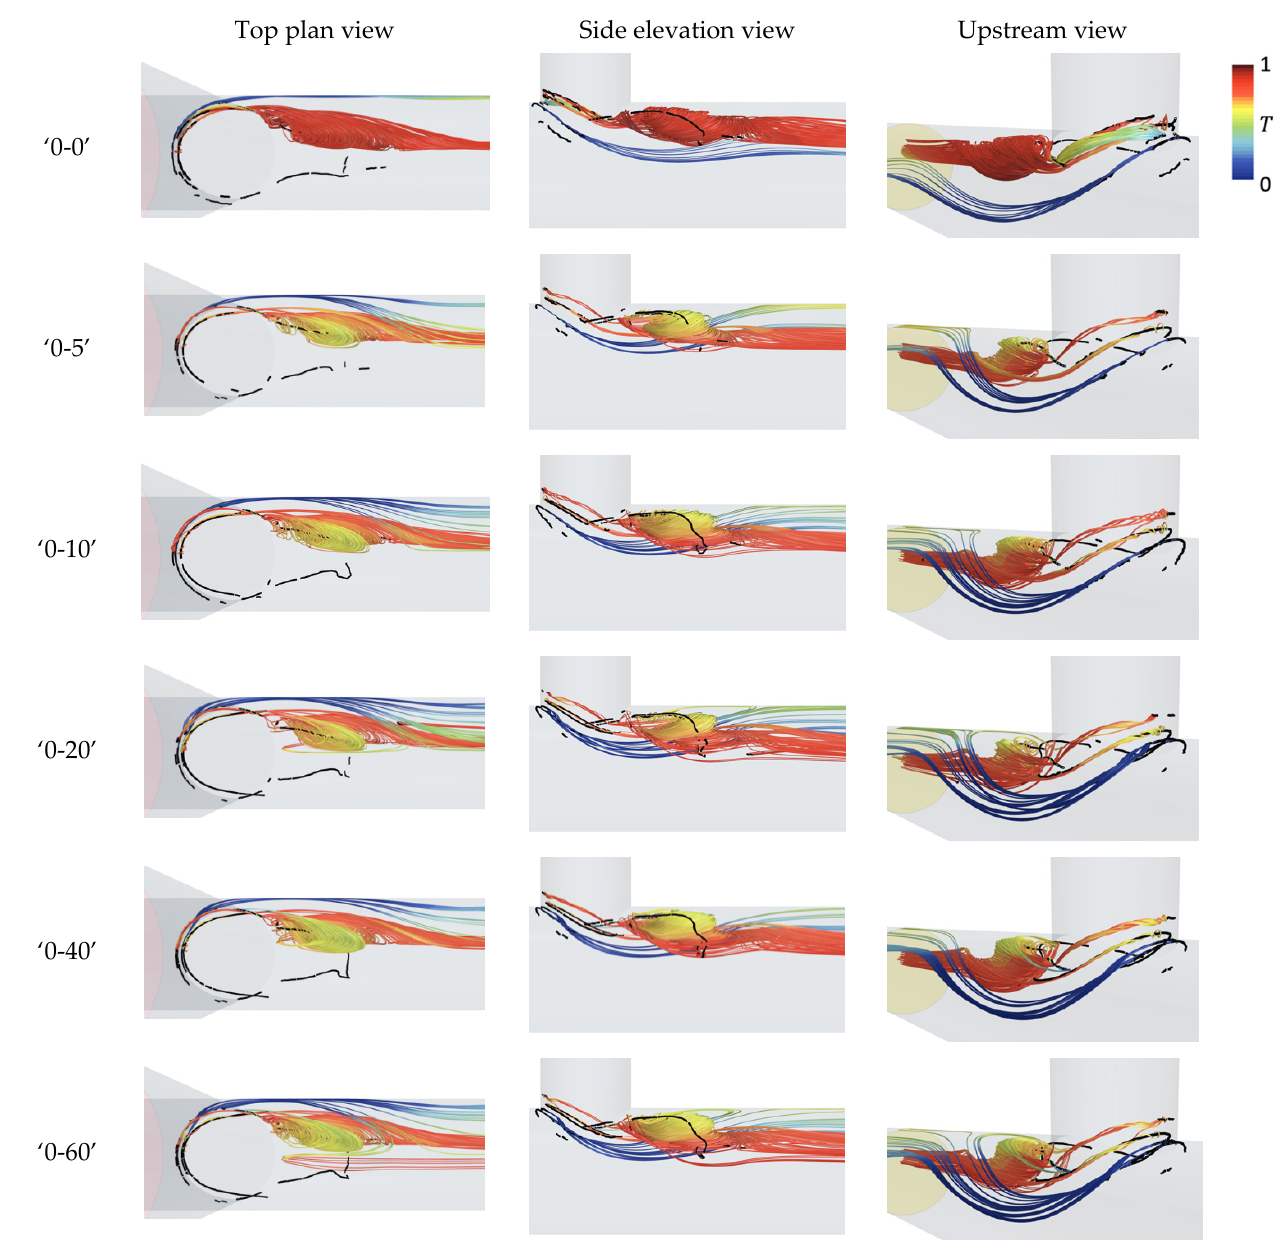
Figure 18. Cases with uniformly distributed BCs at the main inlet—Streamlines generated by vortex core lines (indicated in black) and coloured by 𝑇 ∗ . Left: top plan view, centre: side elevation view, right: upstream view.